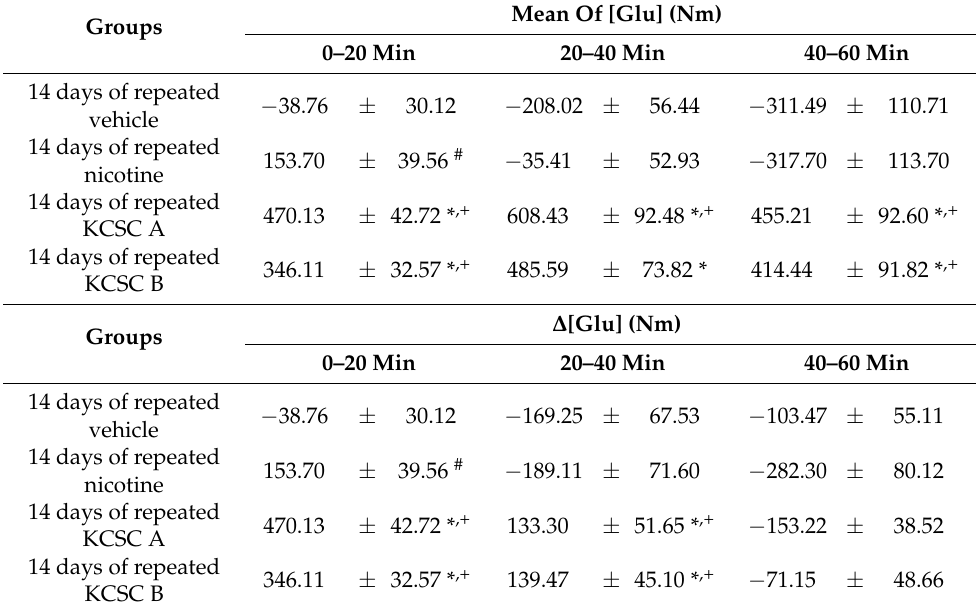
Table 4. Mean glutamate concentrations ([Glu]) and rate of changes in these concentrations ( ∆ [Glu]) in the dorsal striatum at three different time periods after 14 days repeated administrations of vehicle, nicotine, KCSC A, and KCSC B.